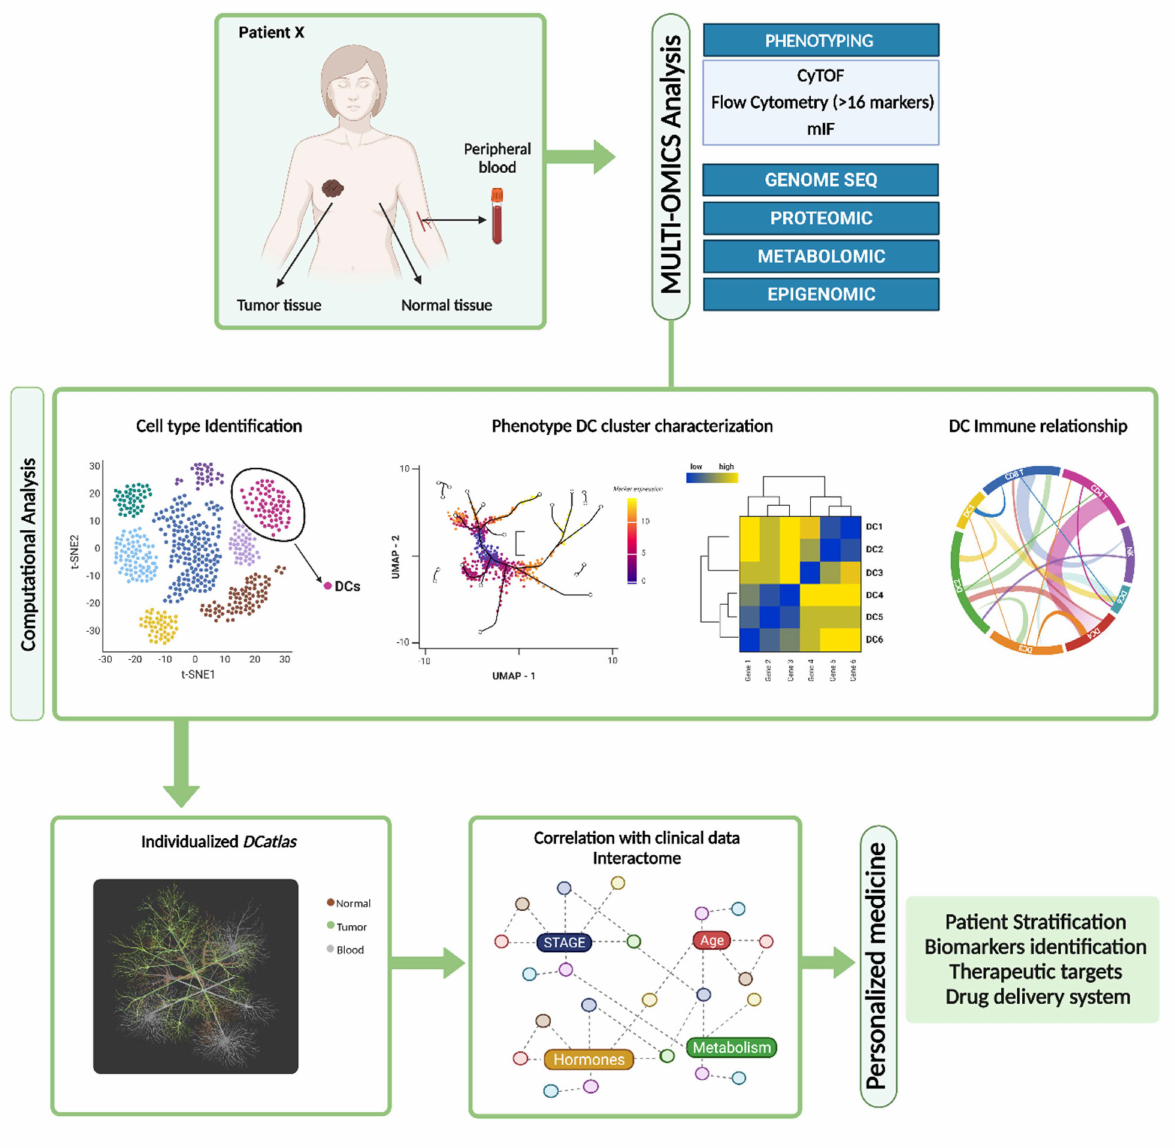
Figure 4. Proposed workflow to expand our understanding of DC biology, functional role and targetability in